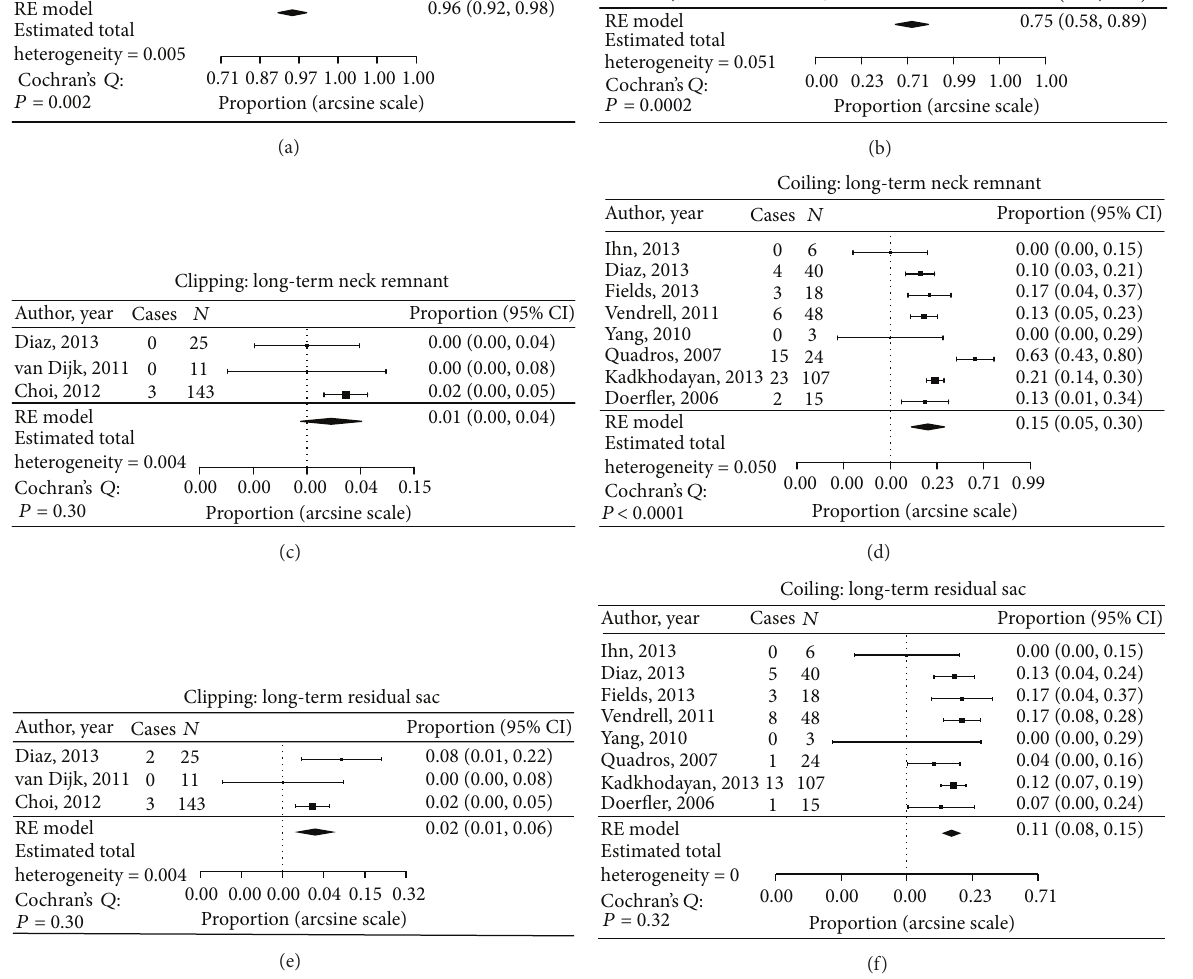
Figure 1: Data analysis of long-term angiographic outcome in both clipped and coiled groups.